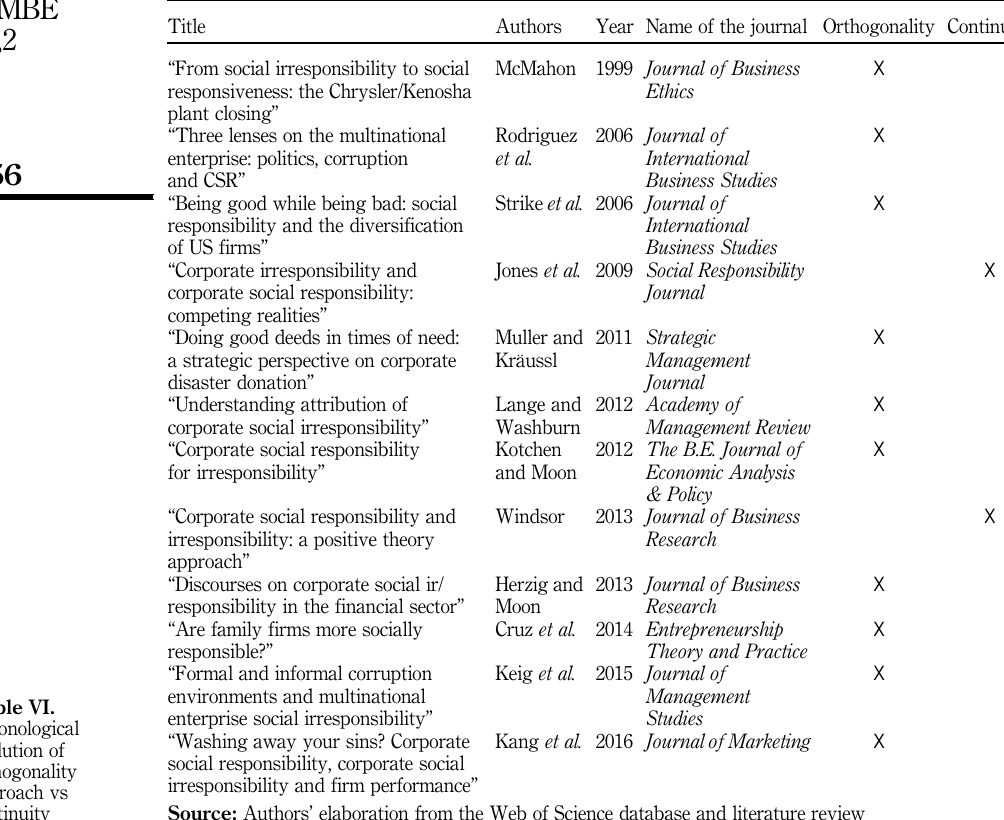
evolution of orthogonality approach vs